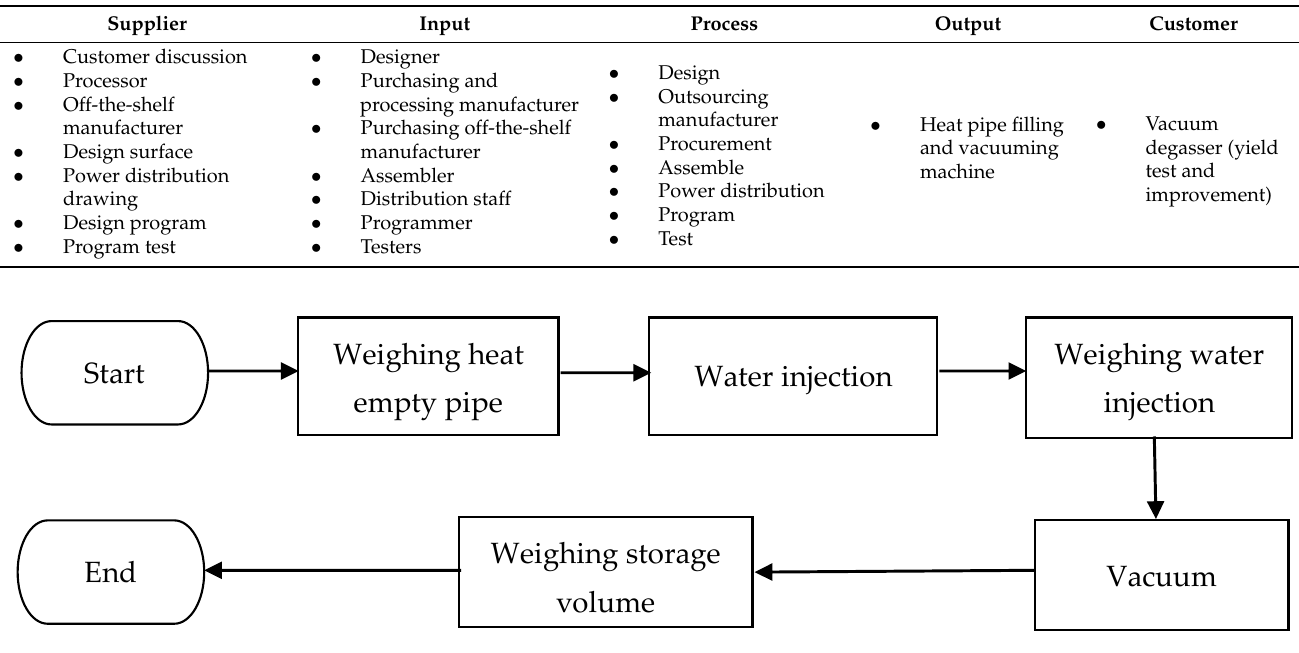
Figure 3. Heat pipe water injection process.